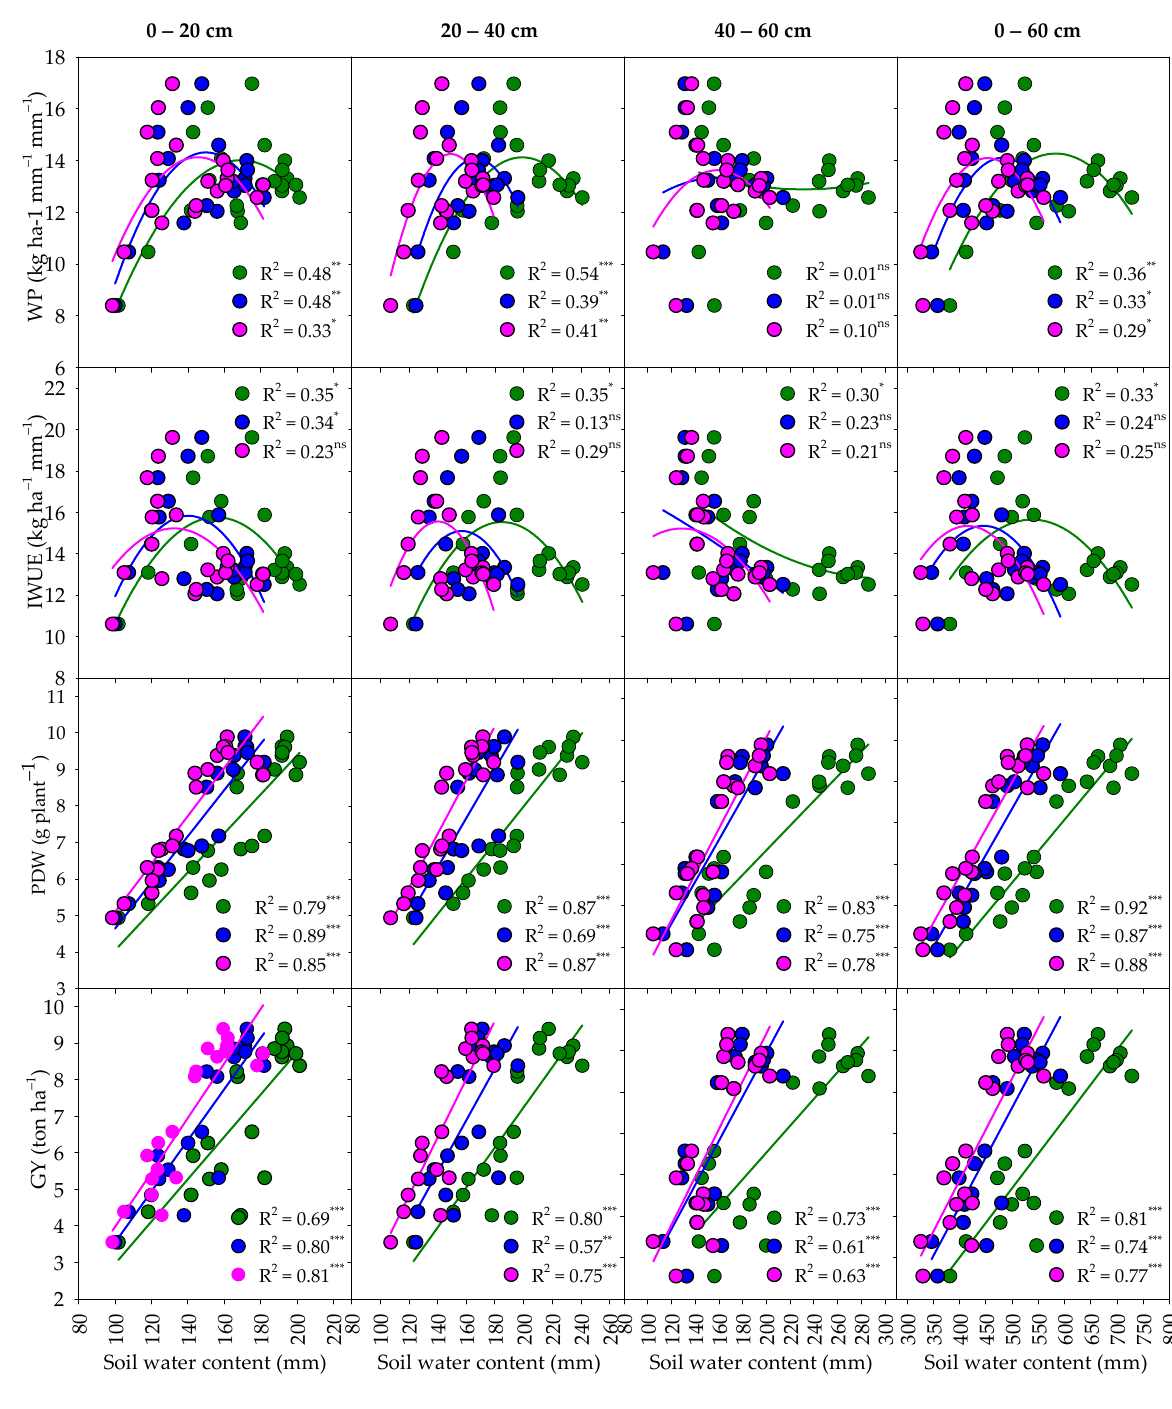
Figure 10. Functional relationship between the soil water storage measured before irrigation at 64 (circle green), 91 (circle blue), and 110 (circle pink) days after sowing at deferent soil depth and grain yield (GY), plant dry weight (PDW), irrigation water use efficiency (IWUE), and water productivity (WP) using the pooled data of tillage, mulching, and irrigation treatments. *, **, and *** indicate significant at p < 0.05, 0.01, and 0.001, respectively; ns indicates not significant.